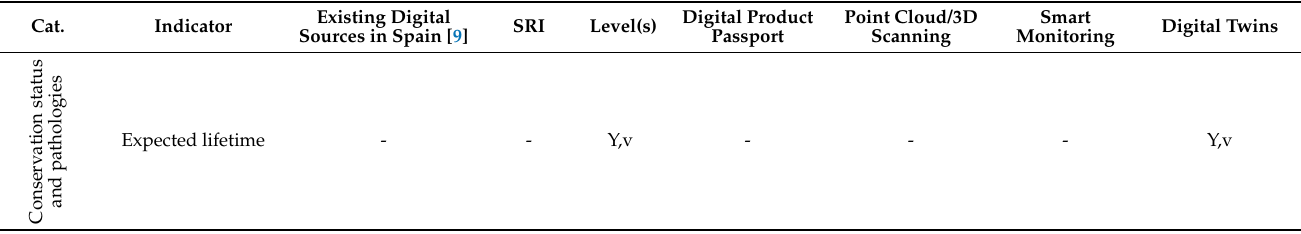
Table A6. Category 6: Conservation status and